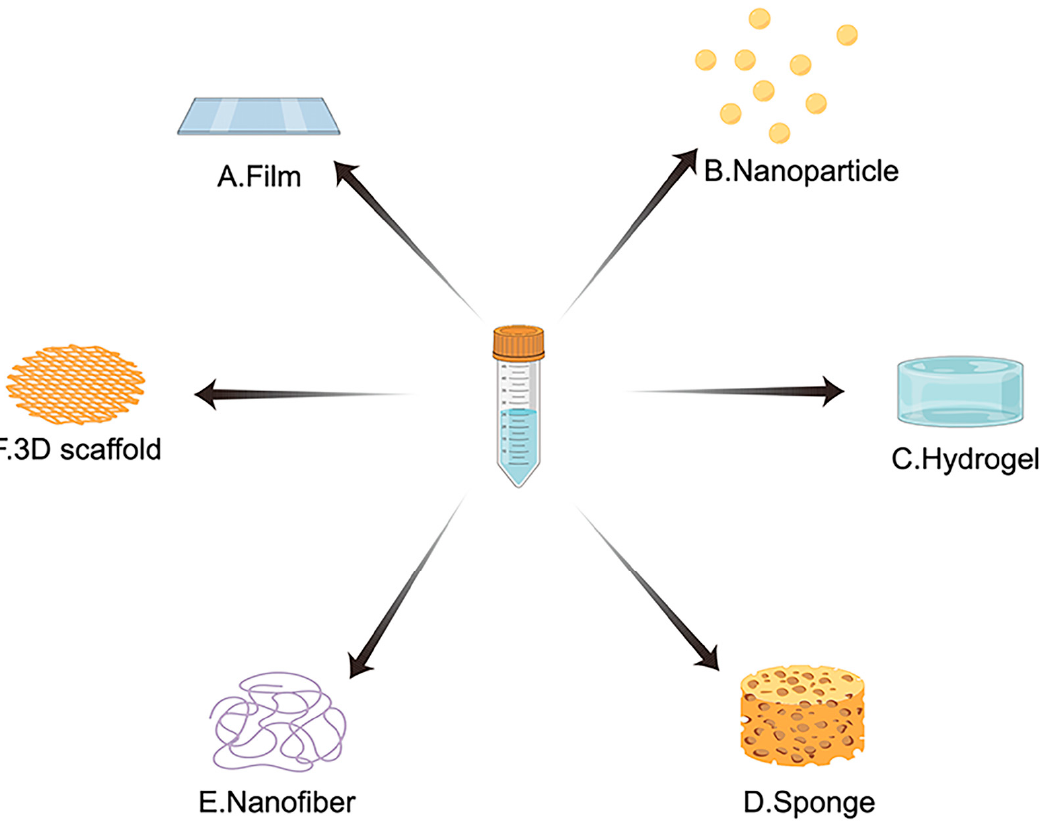
Figure 4. Multiple typical forms of SF as a functional biomaterial for bone tissue engineering (BTE): ( A ) Film; ( B ) Nanoparticle; ( C ) Hydrogel; ( D ) Sponge; ( E ) Nanofiber; ( F ) 3D-printed scaffold.